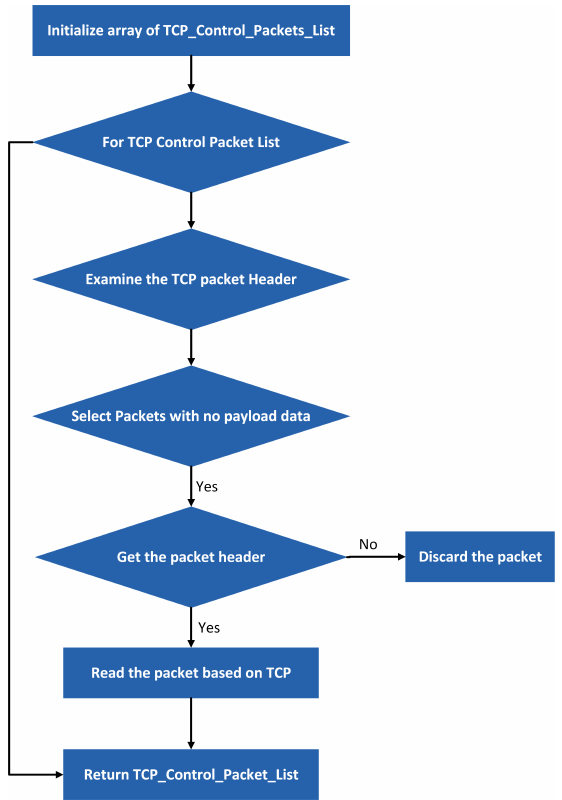
Figure 4. Flow chart for network traffic